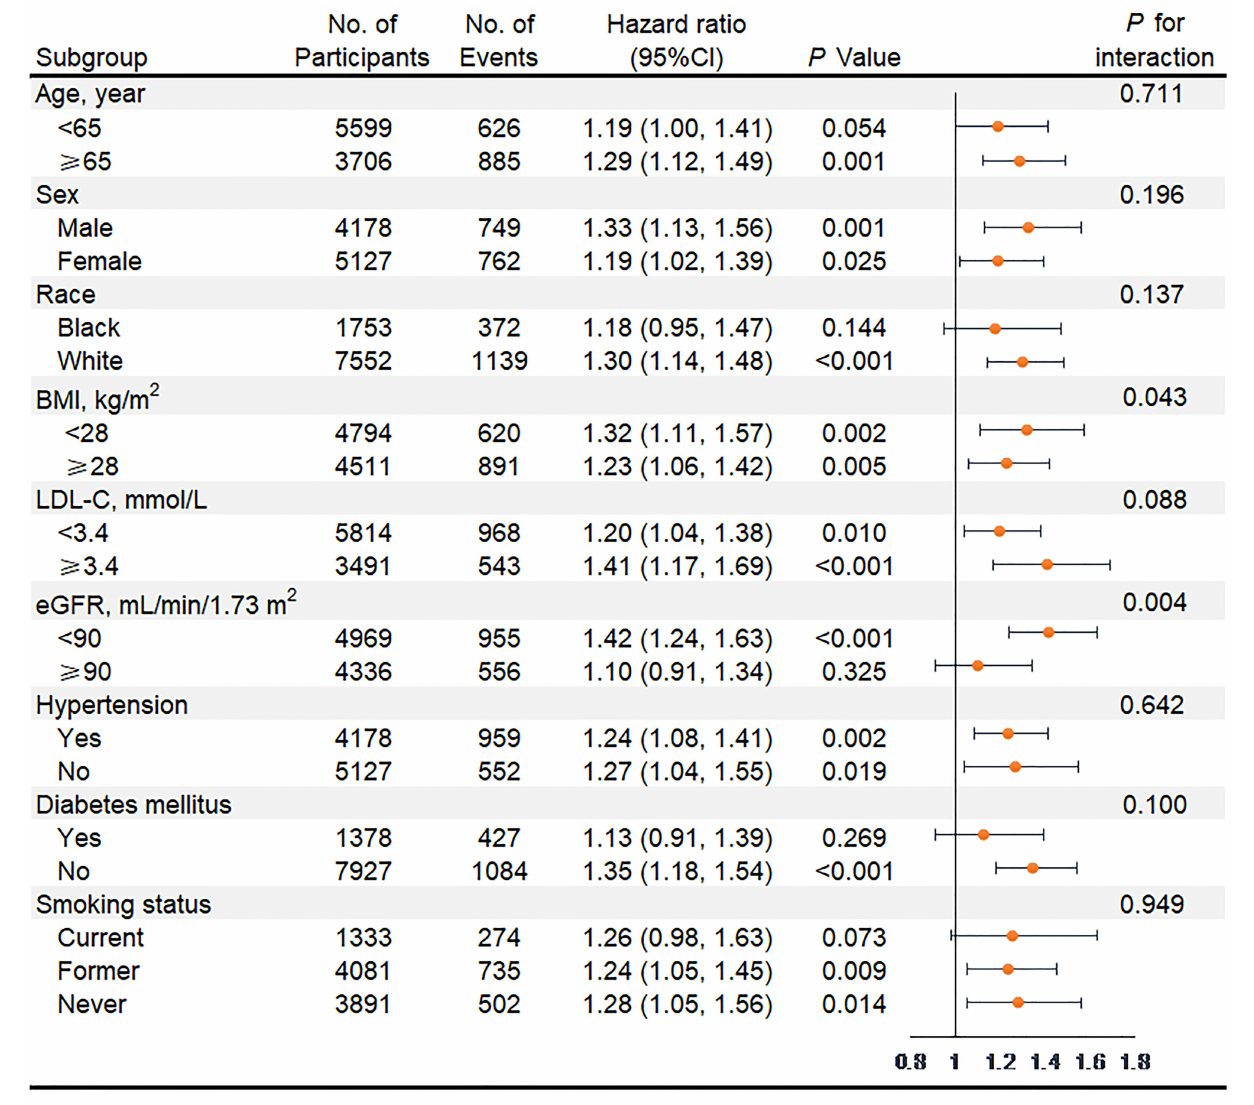
FIGURE 4 | Association of the highest quartile of MAP variability group (VIM Q4) compared with the lower MAP variability group (VIM Q1 + Q2 + Q3) for heart failure in key subgroups. Hazard ratios and 95% CIs were obtained after individually removing the original variable from the Cox Model 3 that adjusted for age, sex, race, BMI, education level, smoking status, drinking status, total cholesterol, LDL-C, HDL-C, triglyceride, fasting glucose, eGFR, prevalent hypertension, diabetes mellitus, coronary heart disease, myocardial infarction, stroke, antihypertensive medicine, aspirin, statin, SBP, DBP at visit 4, and mean of MAP from visit 1 to 4. MAP, mean arterial pressure; VIM, variability independent of the mean; BMI, body mass index; LDL-C, low-density lipoprotein cholesterol; HDL-C, high-density lipoprotein cholesterol; eGFR, estimated glomerular filtration rate; SBP, systolic blood pressure; DBP, diastolic blood